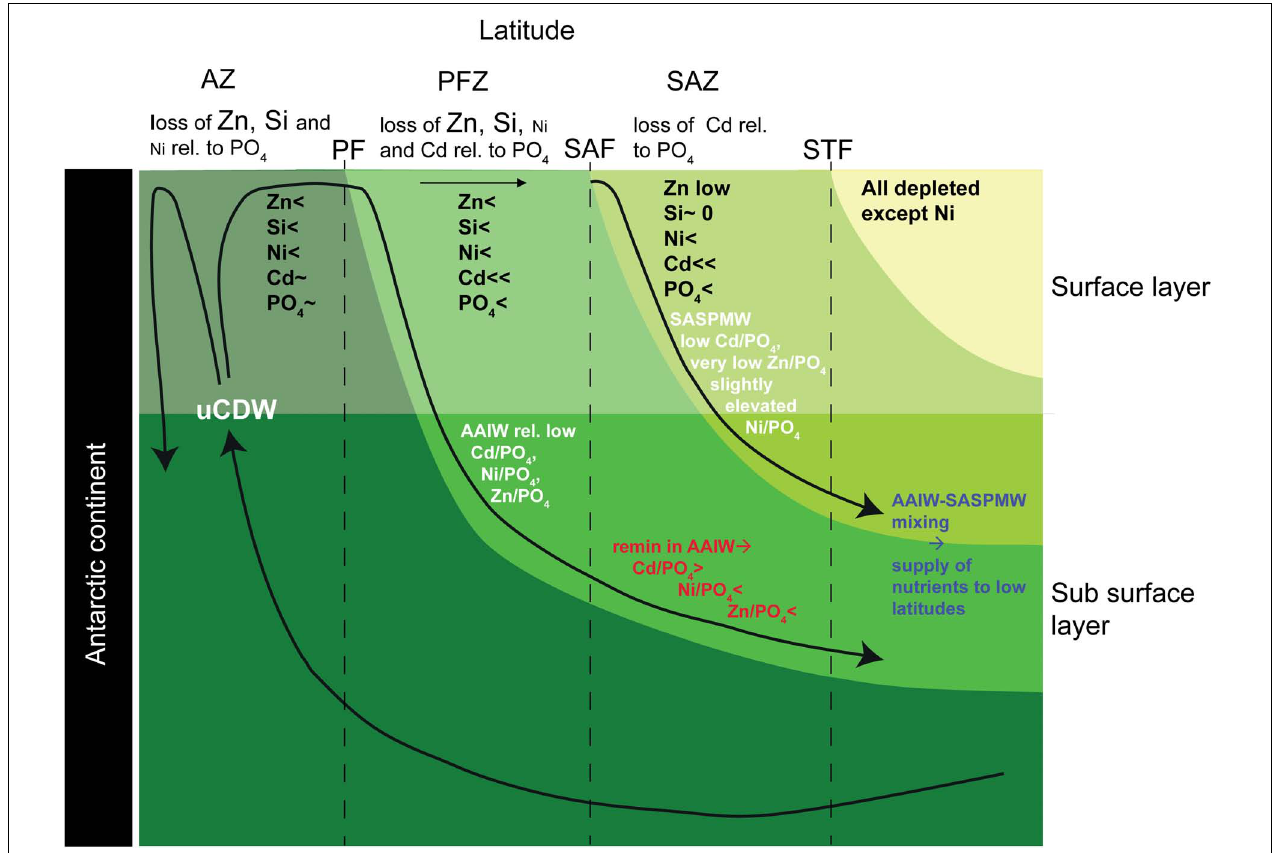
FIGURE 7 | Conceptual model of trace metal uptake and export in the Southern Ocean and the influence on the Metal/PO 4 ratio of the Antarctic origin water masses. The uptake of the various nutrients is indicated for the surface layer in the different latitudinal zones ( < denotes uptake, ∼ denotes no or limited uptake, << denotes rapid depletion). Additionally, effects on the Metal/PO 4 ratios due to uptake and remineralization are indicated for the AAIW and SASPMW that play an important role in supplying nutrients to the Atlantic Ocean. This figure was inspired by the figure by Sarmiento et al. (2004); their Figure 4.